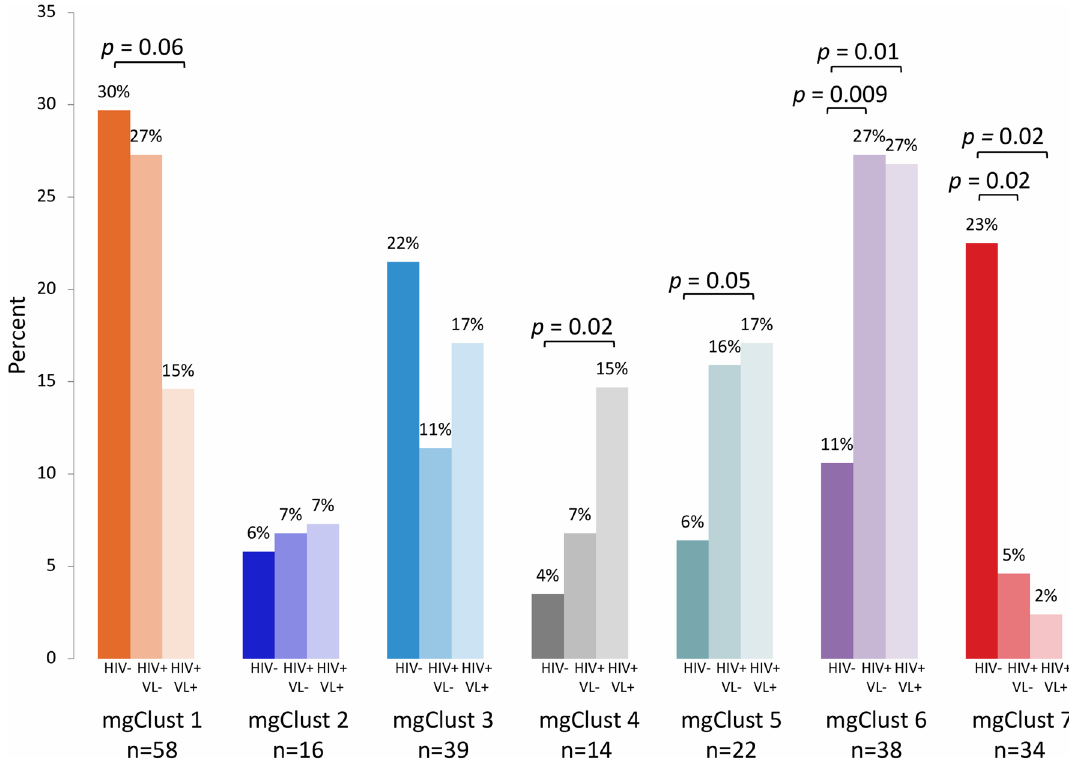
Figure 4. Prevalence of metagenomic community cluster (mgClust) by HIV status and viral load (VL) at 16–20 gestational weeks. Relative percents weighted for sampling and p values calculated by weighted logistic regression with HIV− as comparator group.